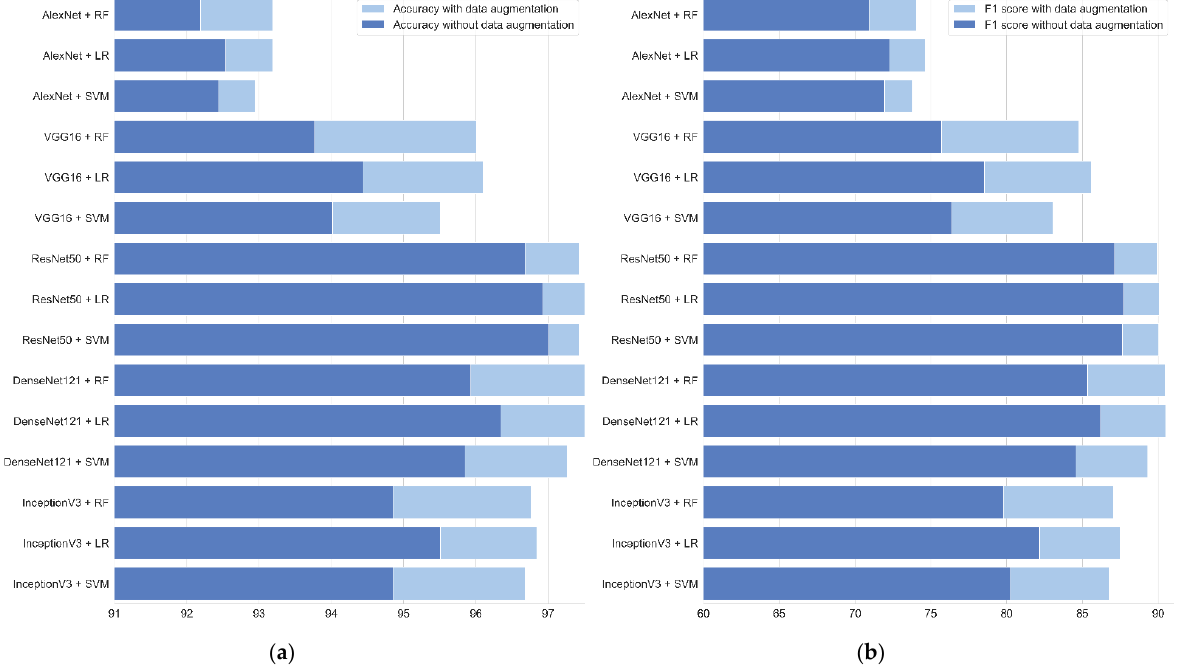
Figure 6. ( a ) Accuracy of model ensemble; ( b ) F1 score of model